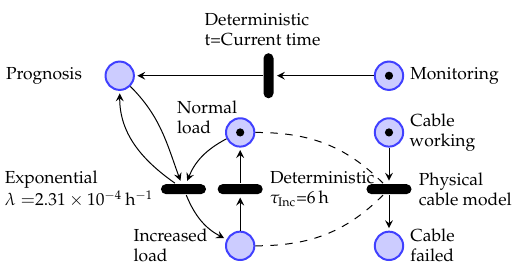
Figure 16. Stochastically switching grid load model implemented as use case, including the switching from monitoring to prognostics state.